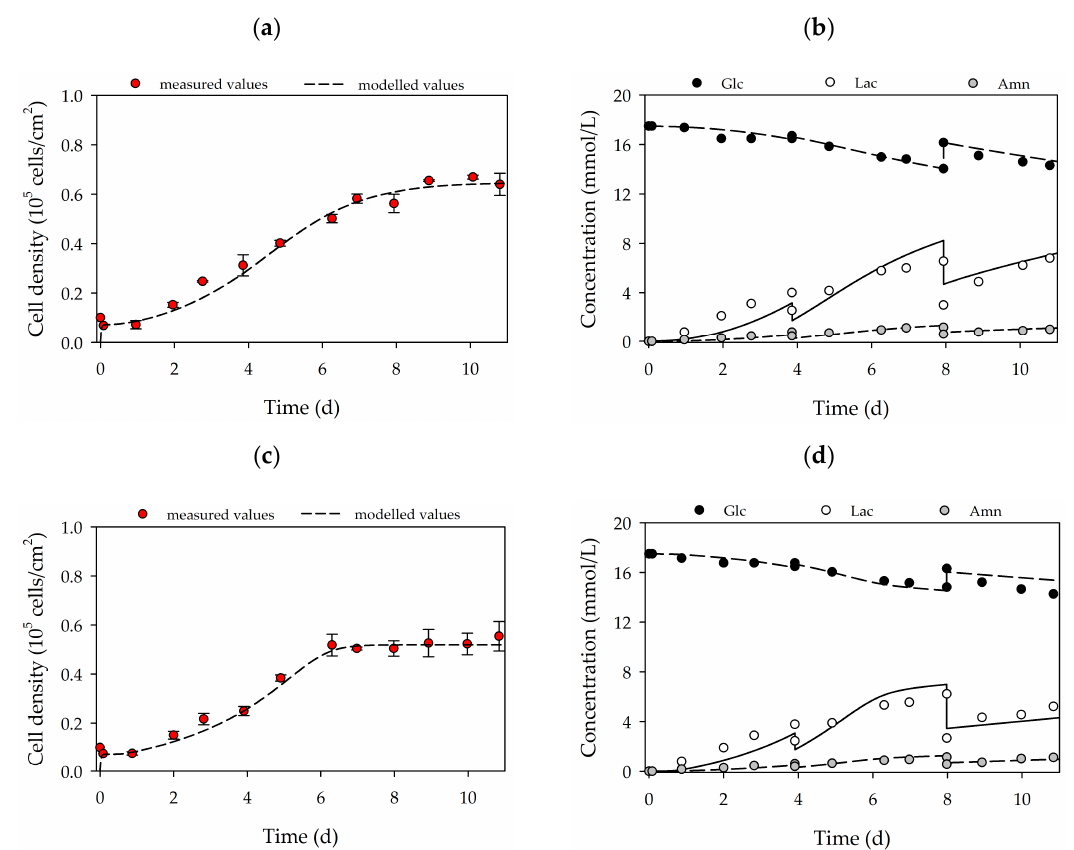
Figure 3. Time-dependent profiles of cell densities ( a , c ) and substrate/metabolite concentrations ( b , d ) in T 25 -flasks. Donor 080 (upper row) and 085 (lower row). Partial medium exchanges of 40% and 60% were performed on days 4 and 8, respectively. The symbols represent the experimentally measured values collected from offline measurements. The lines represent the simulated time courses. Table 3. Overview of the main growth-dependent parameters in the 2D